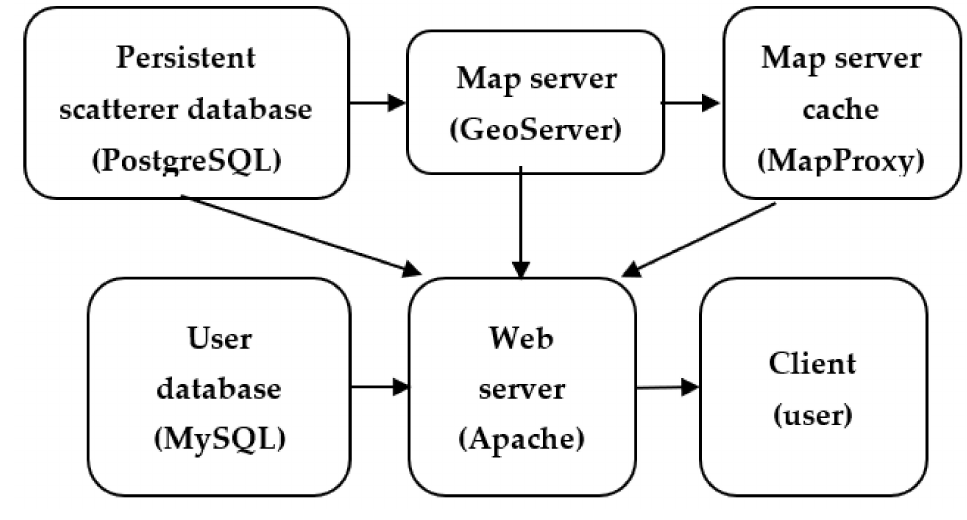
Figure 3. PSTool application